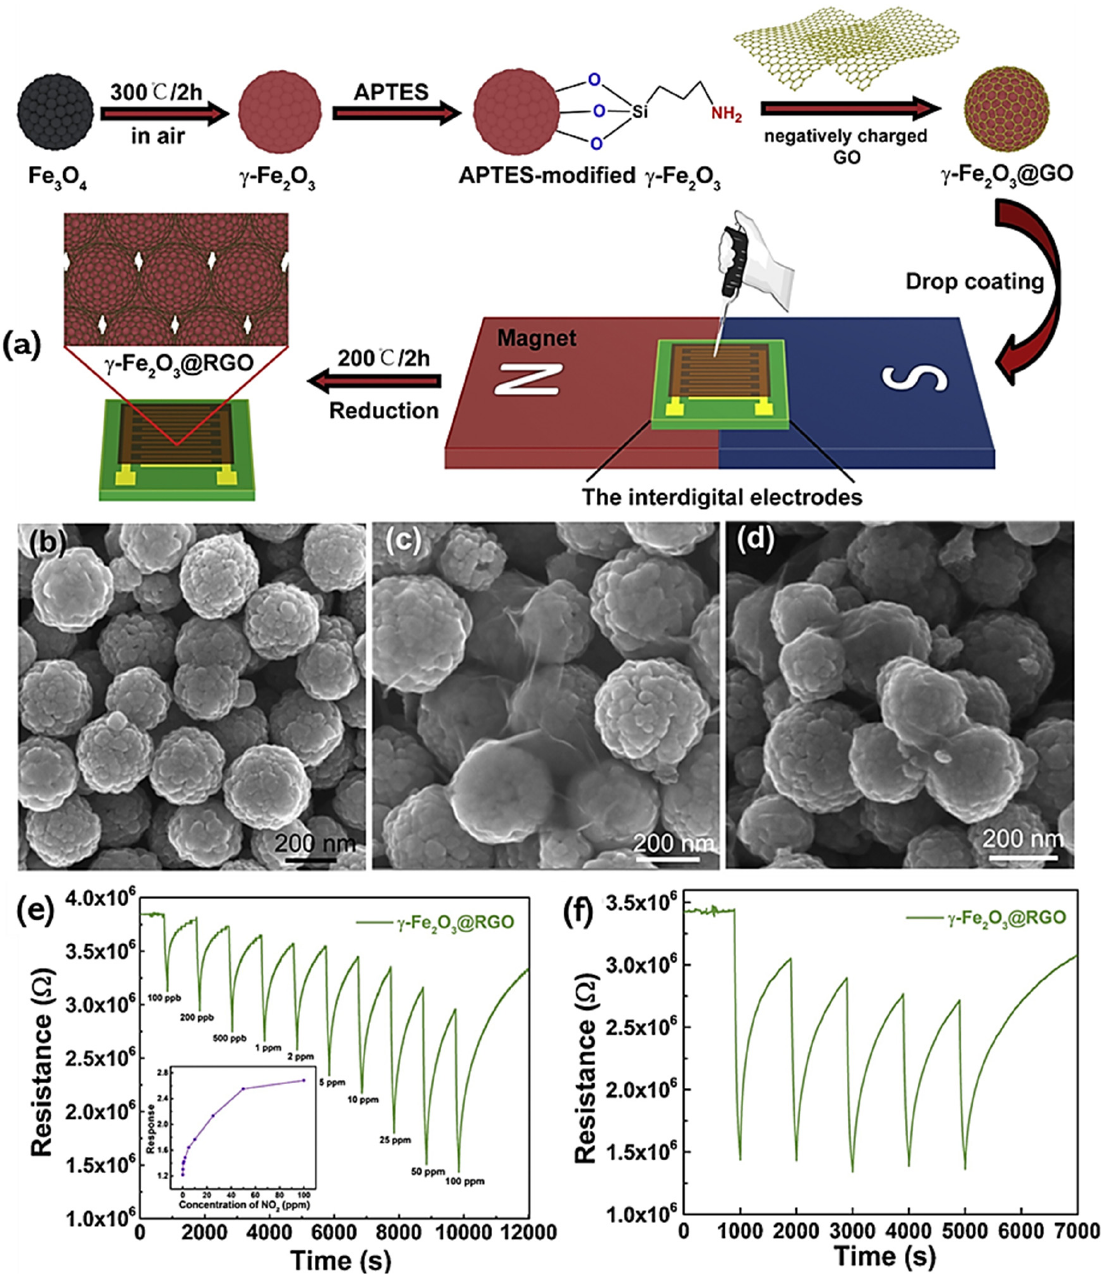
Figure 18 . ( a ) Production process of γ -Fe 2 O 3 @RGO-based gas-sensing devices; SEM images of ( b ) γ -Fe 2 O 3 nanospheres, ( c ) γ -Fe 2 O 3 @GO core-shell hybrids, and ( d ) γ -Fe 2 O 3 @RGO-200 core-shell hybrids; ( e ) variation in sensor resistance under diverse concentrations of NO 2 in real time; and ( f ) the response replicability under 50 ppm NO 2 . Reproduced with permission from [158].